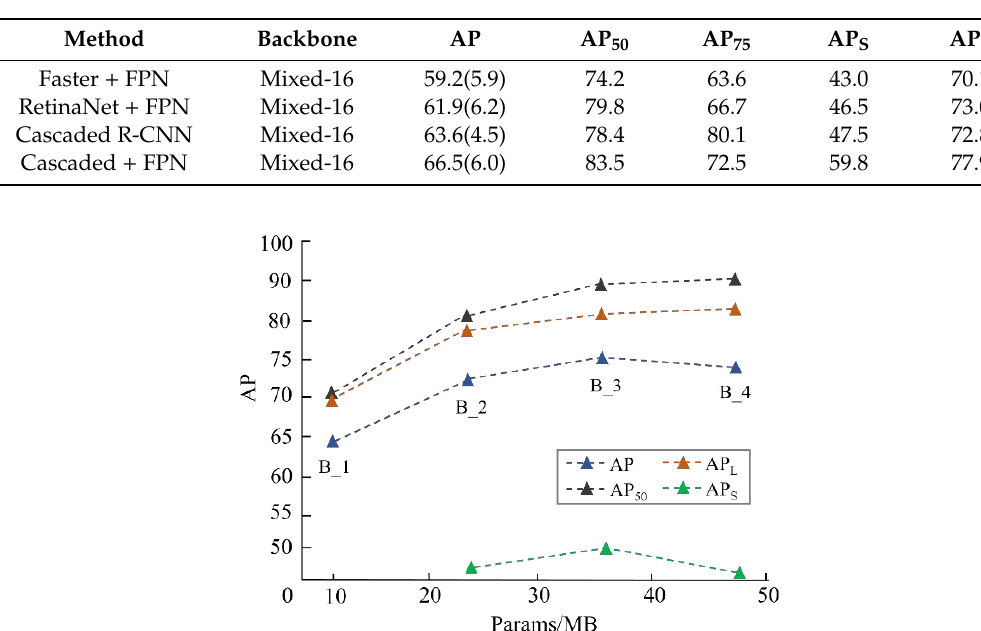
Table 5. Performance of Mixed-16 applied in some generic detectors. Figure 10. Model sizes with Average Precision (AP) for FBDF of different high-efficiency backbones upon Faster R-CNN and FPN.